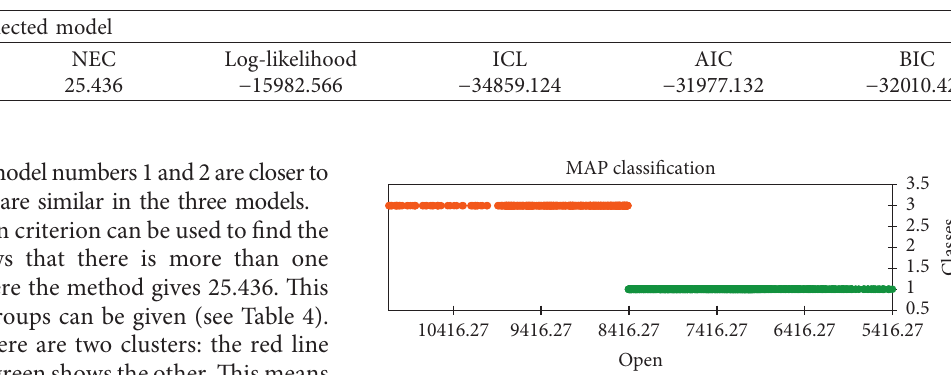
Table 4: Selection criterion for selection model. The NEC criterion is more than one which indicates that there is no clustering structure in the data.